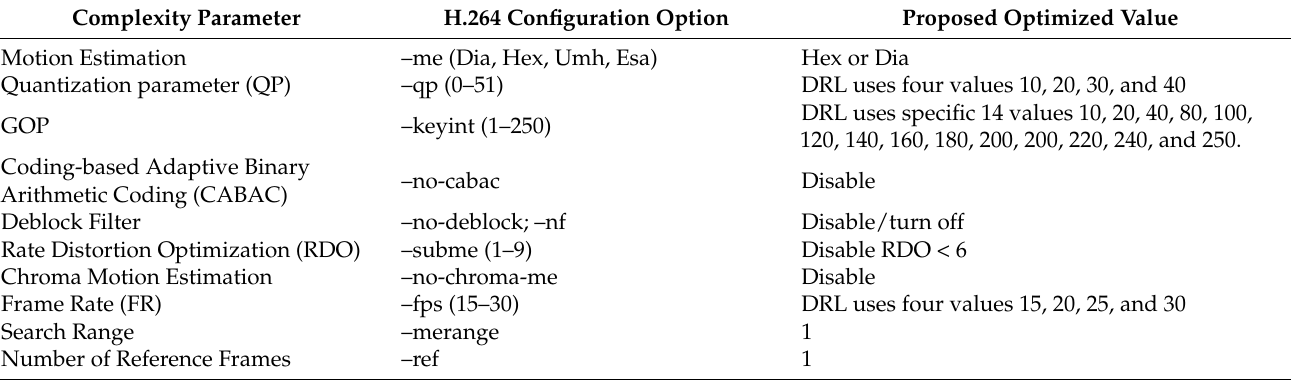
Table 1. H.264 Encoder Configuration